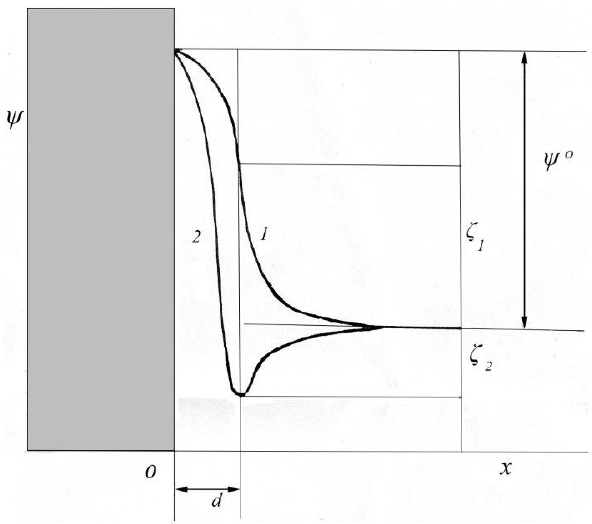
Figure 1. Sketch of the potential distribution ψ( x ) in a flat double layer after Smoluchovski (1914) and Freundlich (1922). The border between the solid (hatched) and the liquid is situated at x = 0. Dis- cussion in the